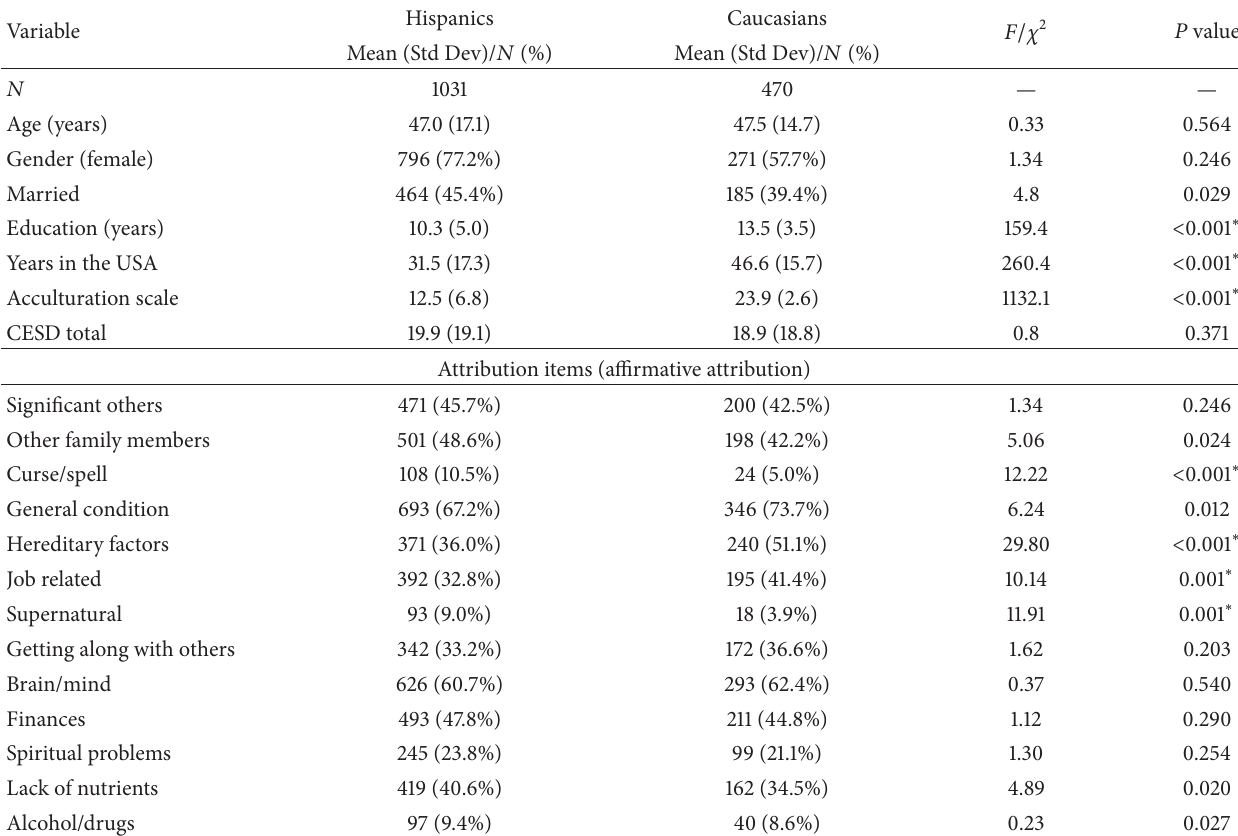
Table 1: Comparison between demographic traits and rates of attribution between Hispanics and Caucasians.